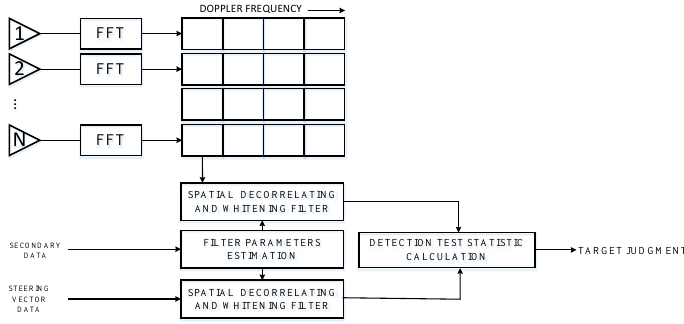
Figure 2. Post-Doppler parametric adaptive matched filter (PD-PAMF) detection